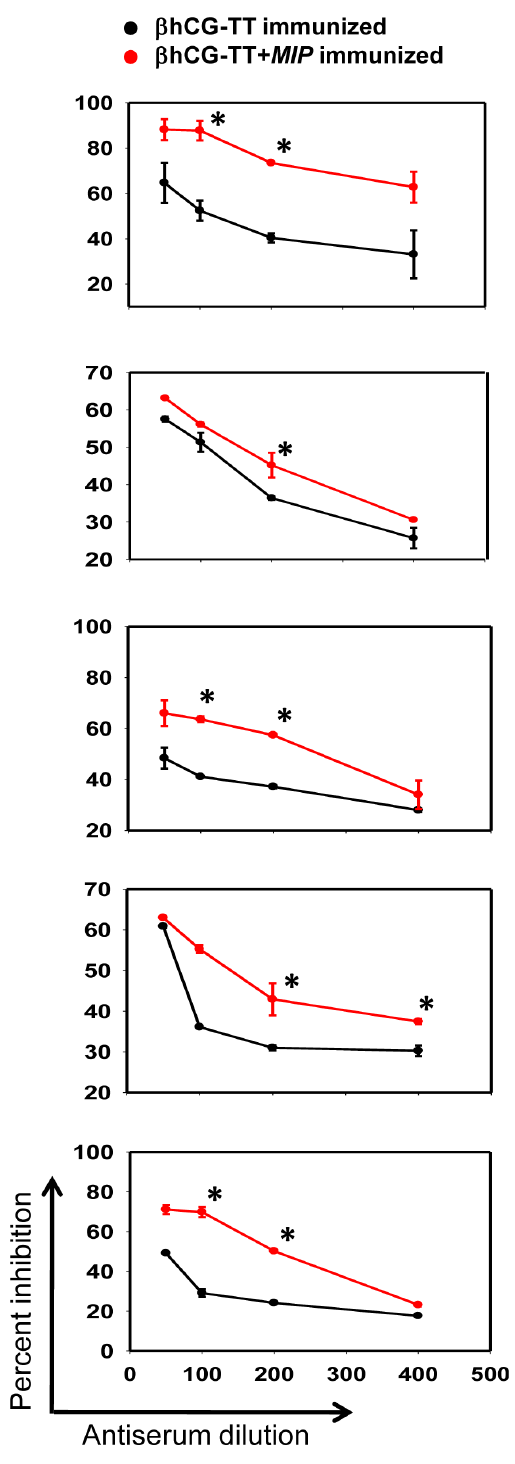
Figure 7. Bioneutralization potential of elicited antisera. hCG neutralization capacity of pooled antisera obtained from animals immunized with alum-adsorbed b hCG-TT or b hCG-TT + MIP , as determined by radio-receptor assay. (A) BALB/c; (B) FVB/J; (C) C57BL/ 6; (D) CBA/Cat and (E) C3H/HeJ. Data is presented as percentage inhibition (over maximal binding obtained in the absence of serum) as a function of antiserum dilution. *p # 0.05 versus corresponding value for b hCG-TT elicited